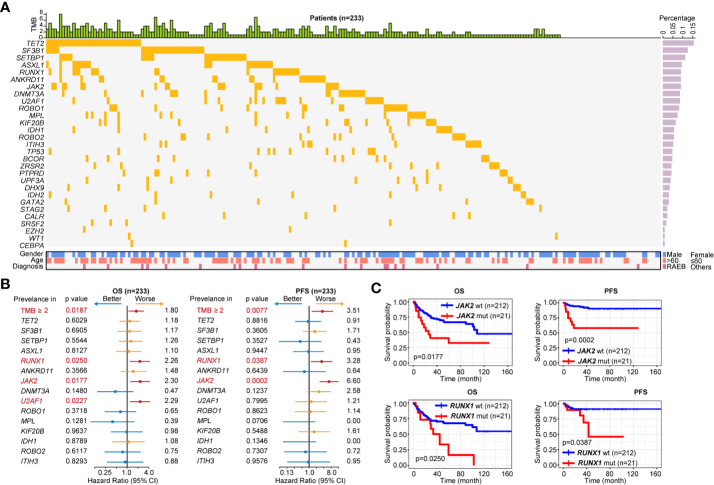
Gene mutation pattern of patients with LR-MDS. (A) Gene mutation pattern of patients with LR-MDS (n = 233). (B) Overall survival (OS) and progression-free survival (PFS) analysis of highly recurrent mutated genes among patients with LR-MDS (n = 233). (C) Kaplan-Meier curves for OS and PFS according to mutation status of JAK2 (top) and RUNX1 (bottom).